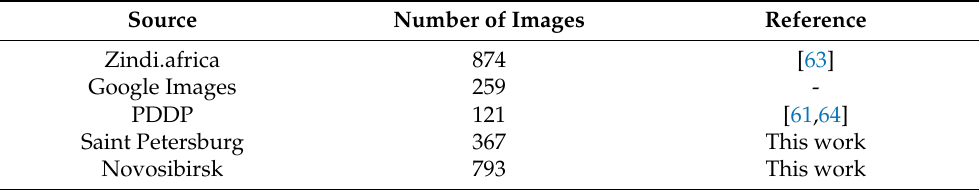
Table 1. Sources of images in the dataset Wheat Fungi